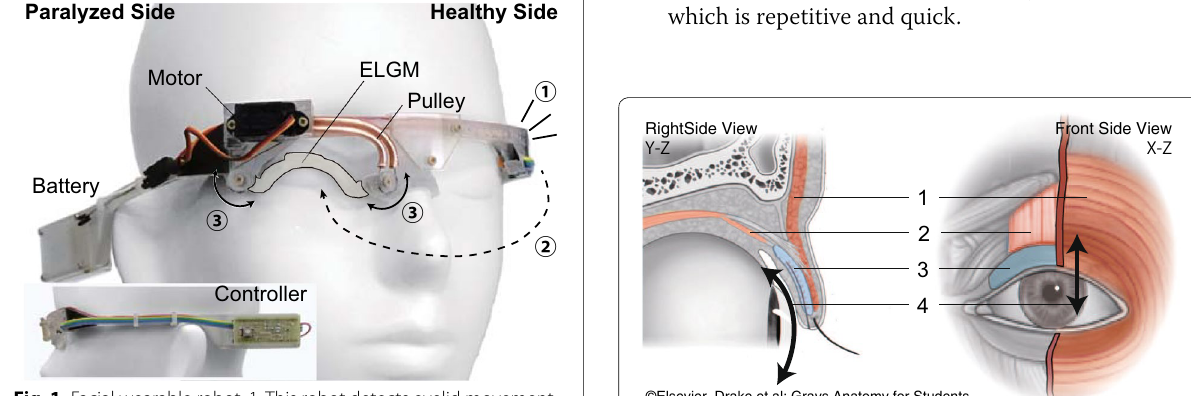
Fig. 1 Facial wearable robot. 1. This robot detects eyelid movement on the healthy side. 2. Eyelid movement detection triggers the support. 3. Rotational actuation input from a motor is transmitted to the ELGM via a pulley-wire system to manipulate the eyelid on the paralyzed side. The size of the robot is 155 × 205 × 25 mm, and its weight is 90.1 g [9]